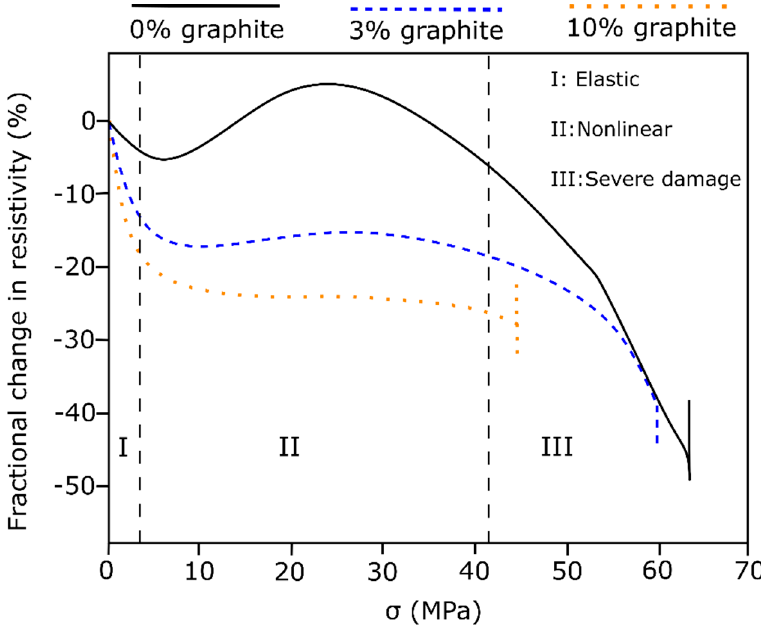
Figure 5. Fractional change in resistivity of slag AAM under monotonic compression for three filler contents, example adapted from [52].